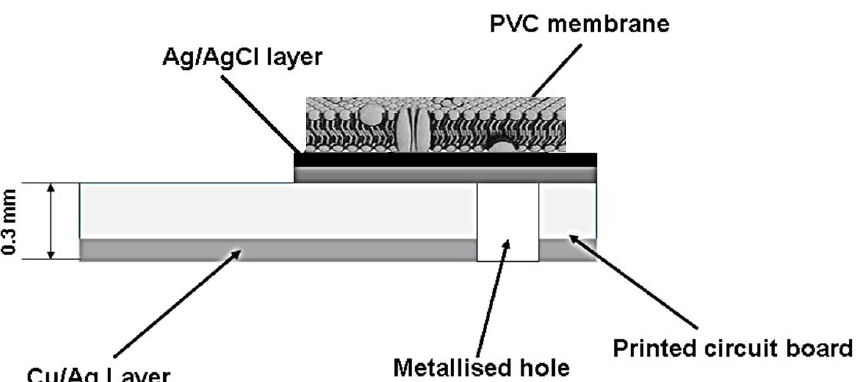
Figure 1. Schematic diagram of the fabricated Ag/AgCl micro-reference electrode based on PVC membrane. PVC